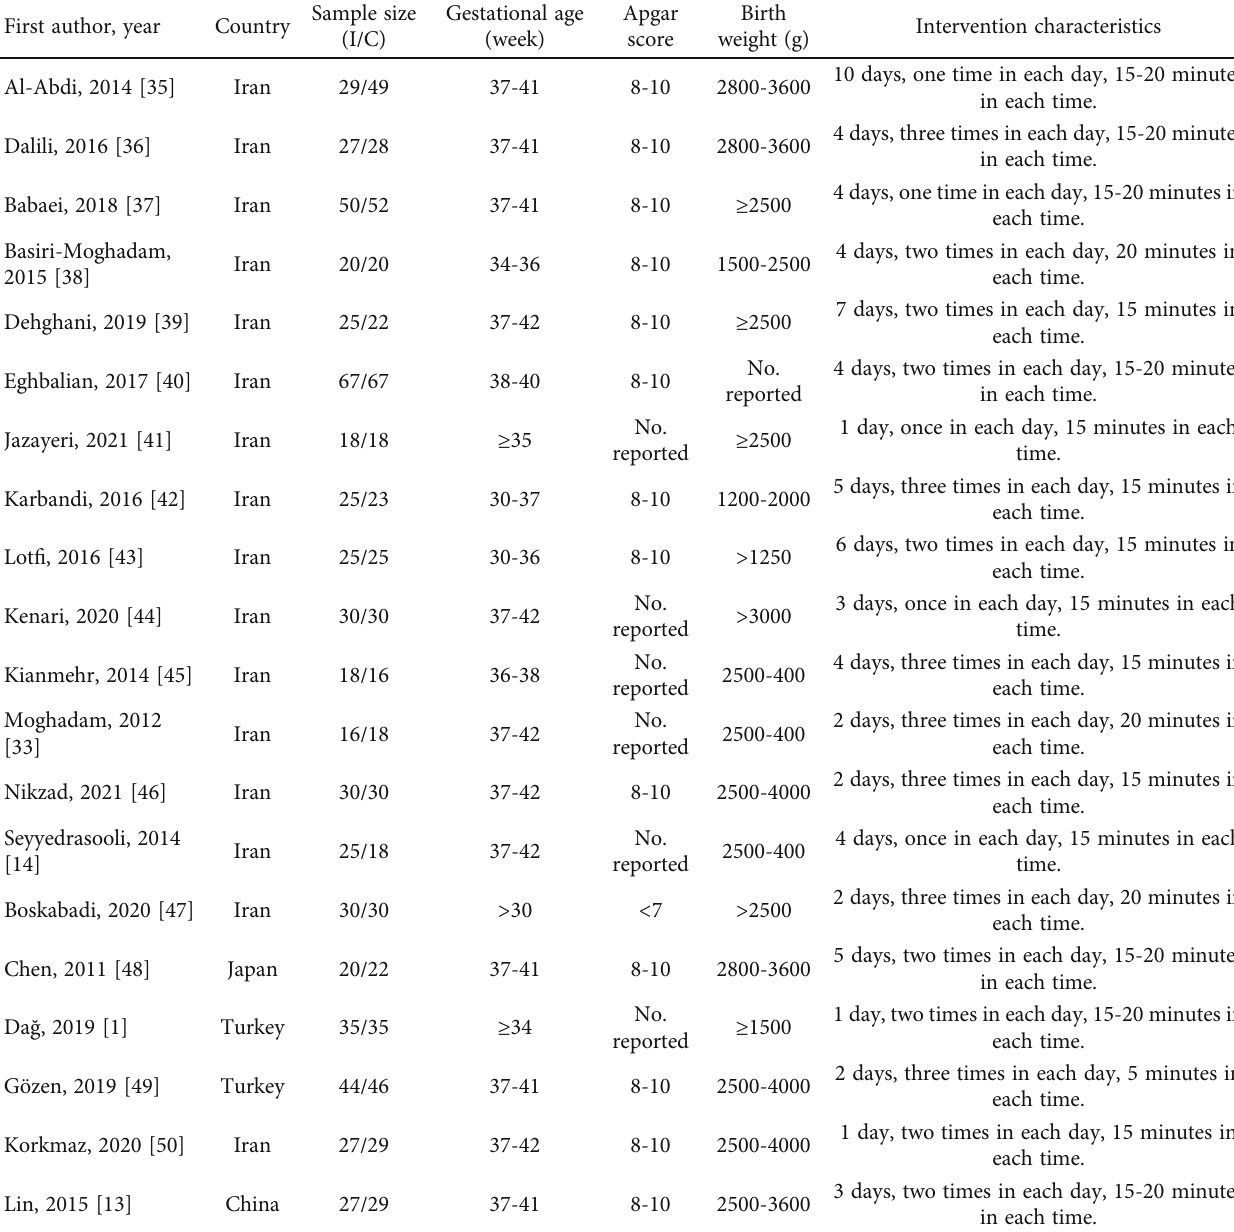
Table 1: Description of eligible studies reporting the e ff ect of massage therapy on neonatal